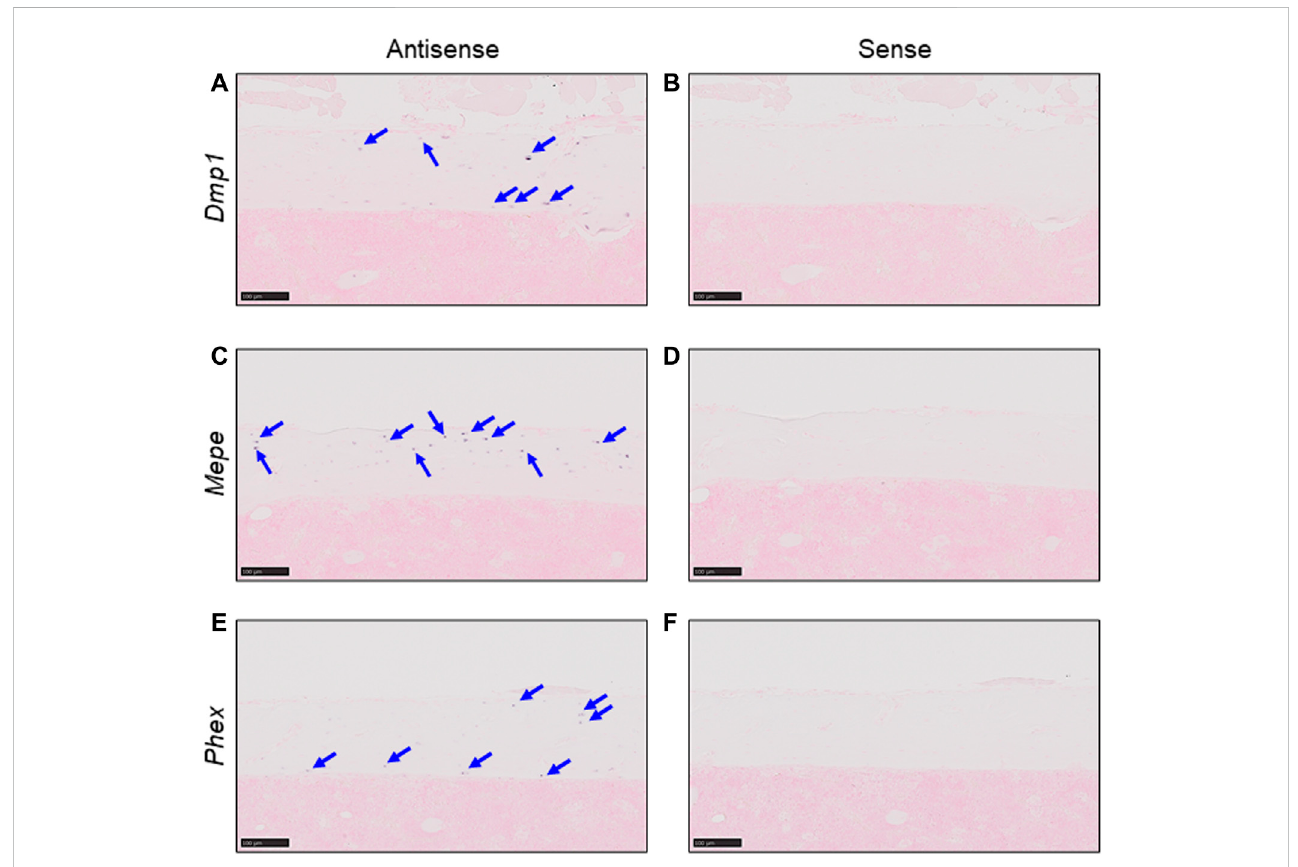
FIGURE 1 DetectionofosteocytemarkermRNAusing insitu hybridization.Expressionofosteocyte markers wasdetectedinserial sections fromuntreatedC57BL/ 6J murine femurs by in situ hybridization. (A,B) Expression of Dmp1 in cortical bone. (C,D) Expression of Mepe in cortical bone. (E,F) Expression of Phex in cortical bone. Markers detected using antisense probes [panels (A, C, E) ] and sense probes [panels (B, D, F) ] (Scale bar: 100 μ